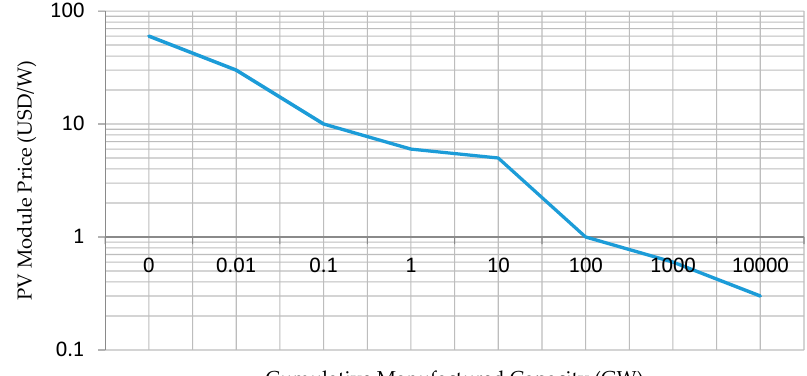
Figure 1. Projected economies of scale of photovoltaic (PV).